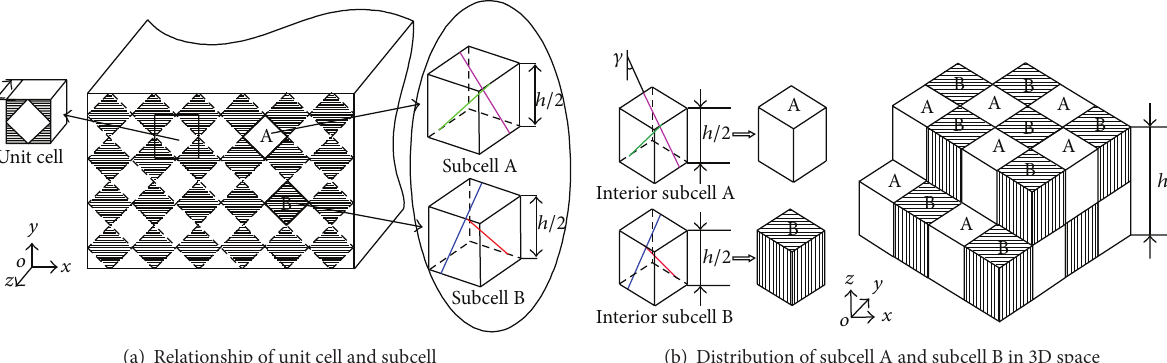
Figure 2: Unit cell composition of 3D rectangular braided composites.